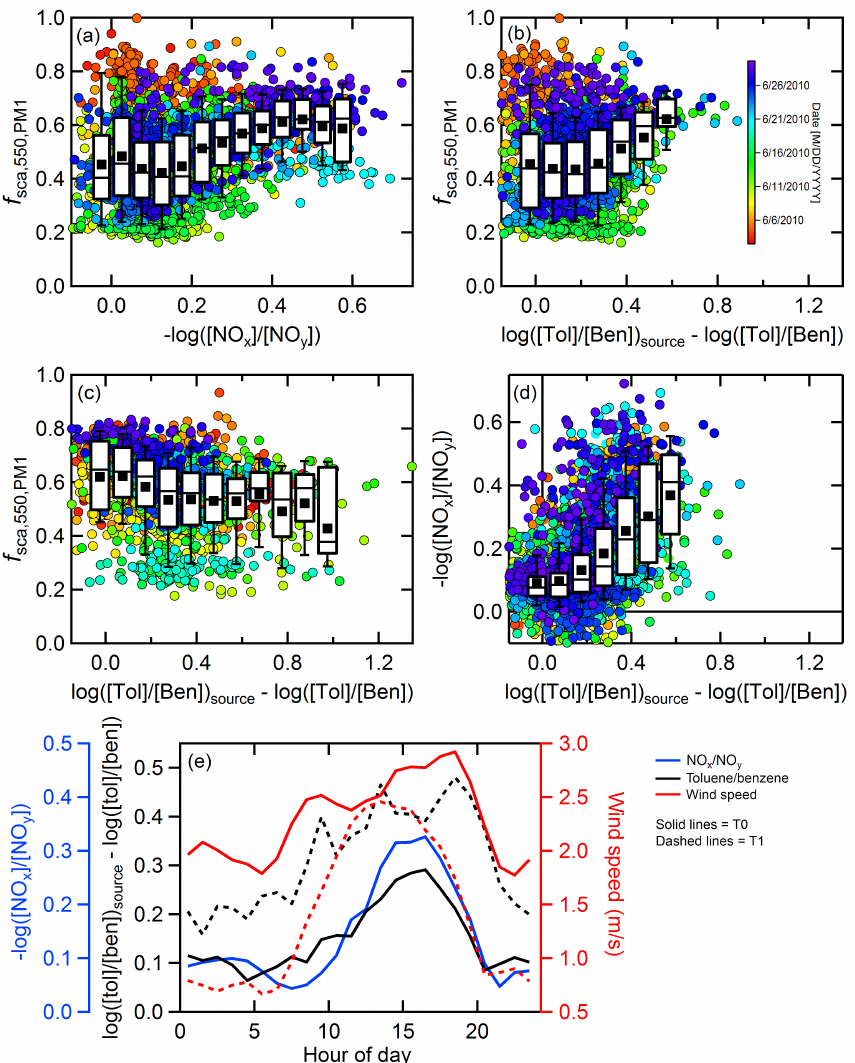
Figure 3. Submicron fraction of scattering for the T0 and T1 sites as a function of photochemical age proxies. Observations at T0 using the (a) NO x /NO y ratio and the (b) toluene/benzene ratio and at T1 for the (c) toluene/benzene ratio as the PCA proxy. Individual measurements (averaged to 10min) are colored by time. (d) The relationship between the two PCA estimation methods at T0. (e) The diurnal variation in the PCA estimation methods and the measured wind speed for T0 (solid lines) and T1 (dashed lines). Box and whisker plots show the median (line), mean (square) upper and lower quartile (box) and 10th and 90th percentile